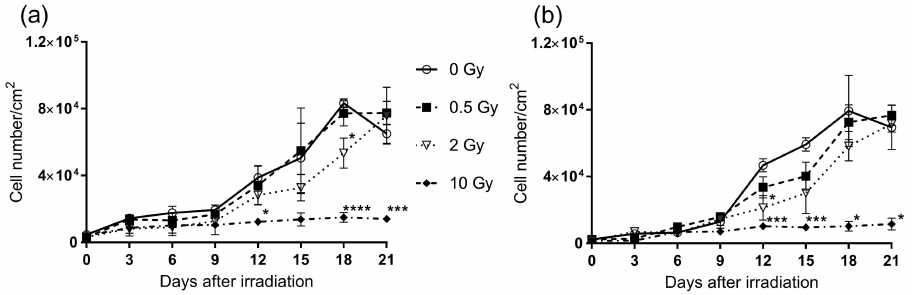
Figure 1. Proliferation of human pre-adipocytes after X-ray irradiation. ( a ) Human primary pre-adipocytes and ( b ) SGBS pre-adipocytes were exposed to 0.5, 2 and 10 Gy X-rays and cultivated over 21 days. Cellcountingwasperformedontheindicateddays. Mean, SEM, N =3, *indicatessignificantdifferencesfrom